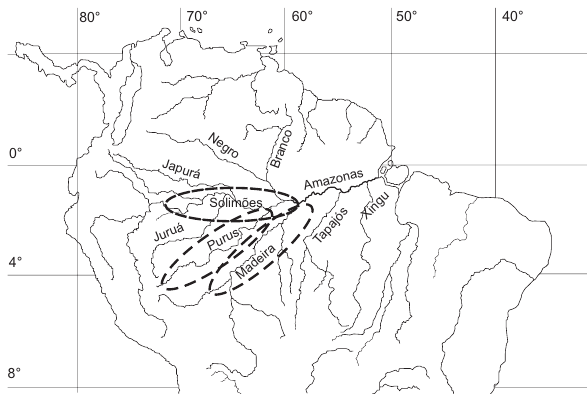
Figura 1. Sub-sistemas da Amazônia Central explotados pela frota pesqueira de Manaus que capturou os exemplares de matrinxã analisados neste